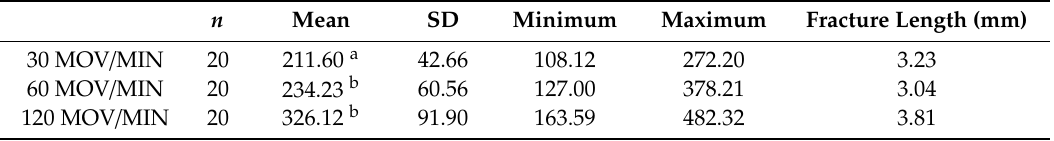
Table 3. Descriptive statistics of the number of cycles of in-and-out movement.